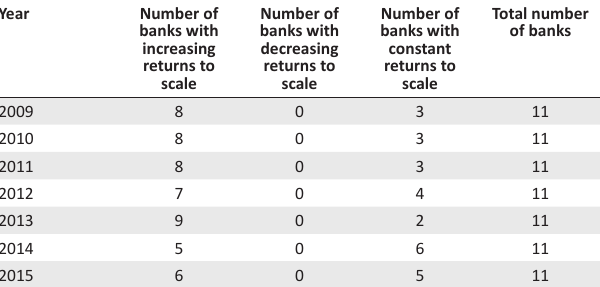
TABLE 3: Sources of scale